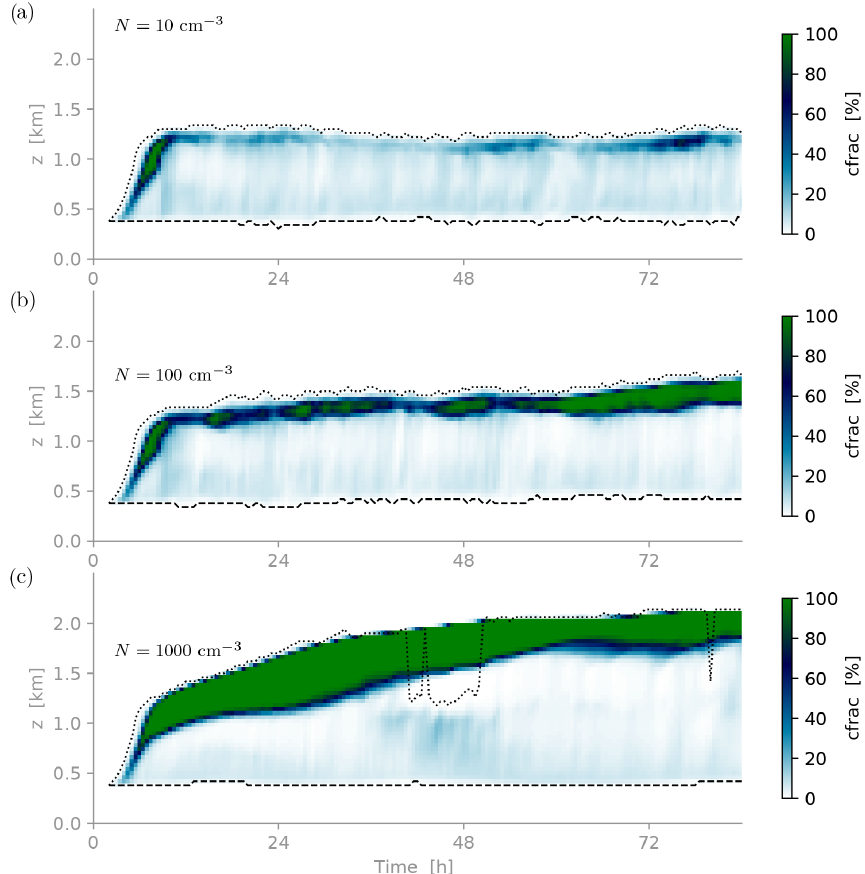
Figure 11. Time–height contour plots of liquid cloud fraction (cfrac) during the three CCN sensitivity experiments. (a) Pristine high-Arctic conditions ( N = 10cm − 3 ). (b) Control conditions observed during ACLOUD RF20 ( N = 100cm − 3 ). (c) Polluted continental conditions ( N = 1000cm − 3 ). Liquid cloud fraction is calculated at each vertical layer as the fraction of grid points where the cloud liquid water content is above the threshold (set to 0.01gm − 2 for cloud liquid